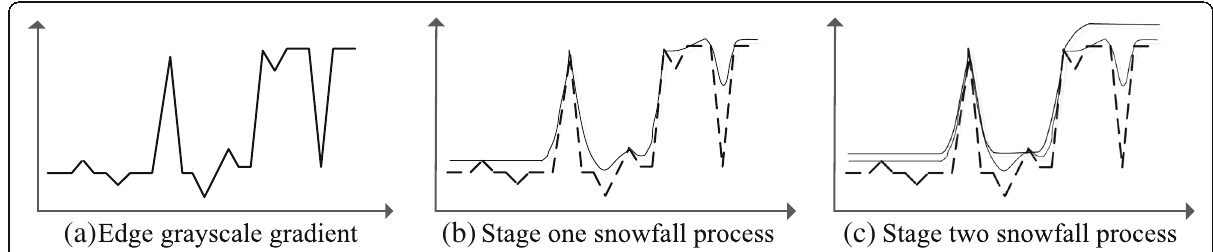
Fig. 1 Snowfall processing illustration. a Edge grayscale gradient. b Stage one snowfall process. c Stage two snowfall